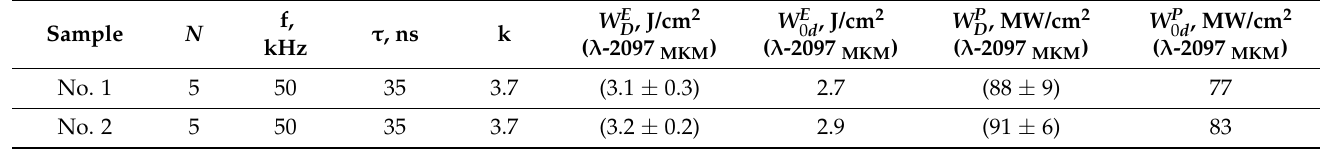
Table 2. The results of the determination of the LIDT of the studied ZGP samples. The values of the energy density W E and the power density W P with a probability of the optical breakdown od od of 0; the average value of the energy density W E and the power density W P , considering the D D measurement error; Student’s coefficient k with a confidence probability of 0.98; and the number of measurements,